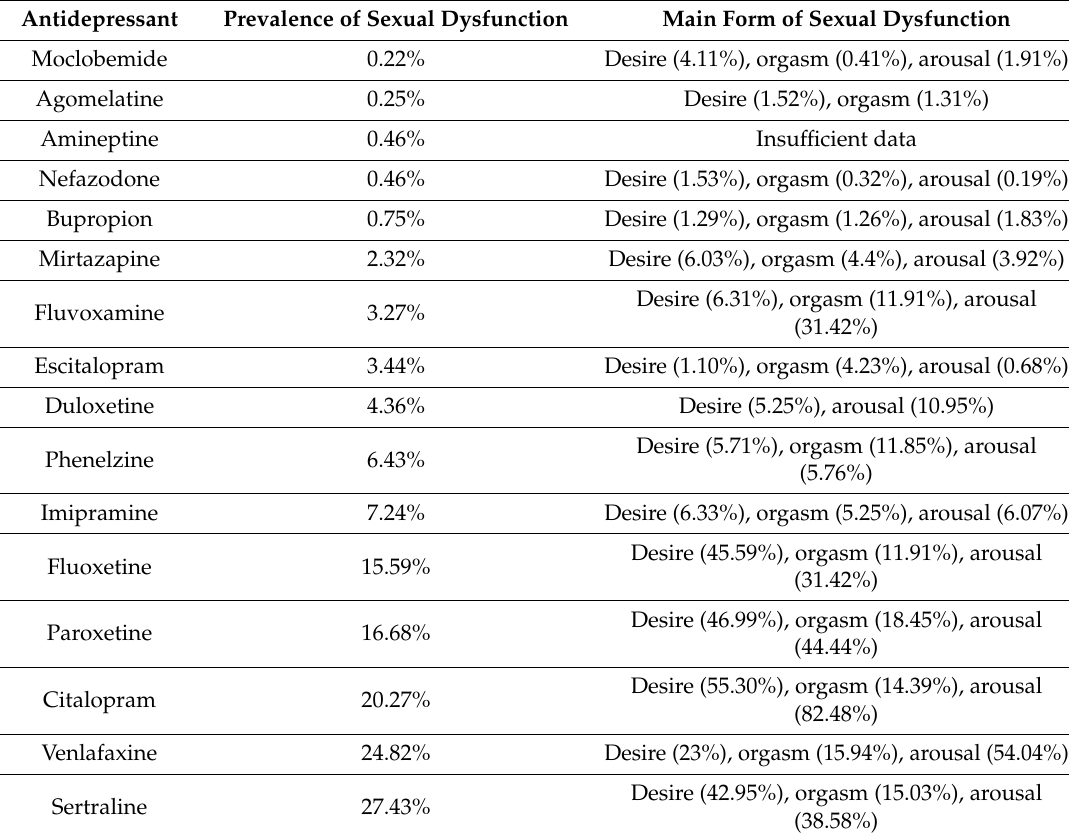
Table 1. Meta-analysis of the prevalence of sexual dysfunction in patients taking antidepressants [3]. Antidepressant Prevalence of Sexual Dysfunction Main Form of Sexual Dysfunction Moclobemide 0.22% Agomelatine 0.25% Amineptine